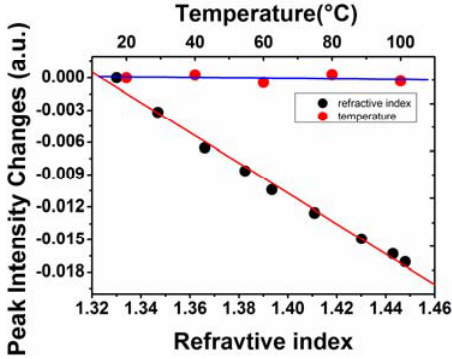
Figure 8. Peak intensity changes as a function of the external refractive index (black) and ambient temperature